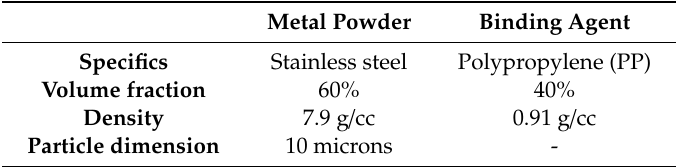
Table 1. Metal powder and binding agent used in MIM